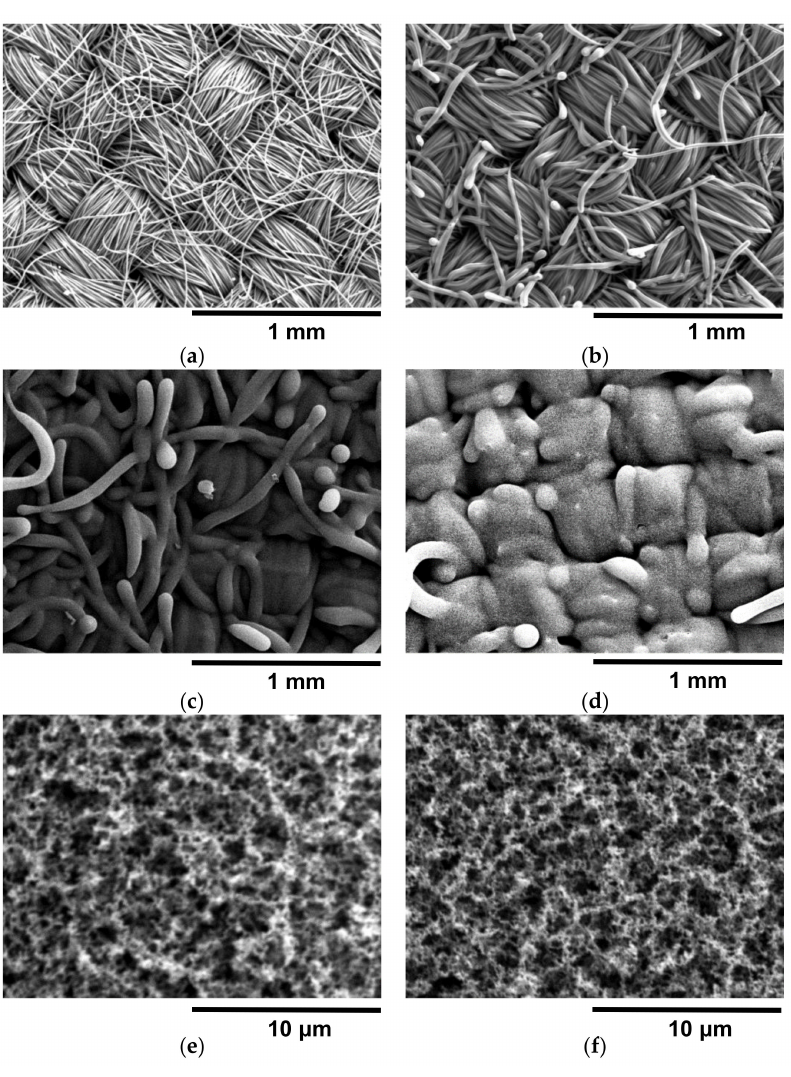
Figure 2. Top-view SEM images of the ( a ) unmodified carbon cloth and those modified by candle